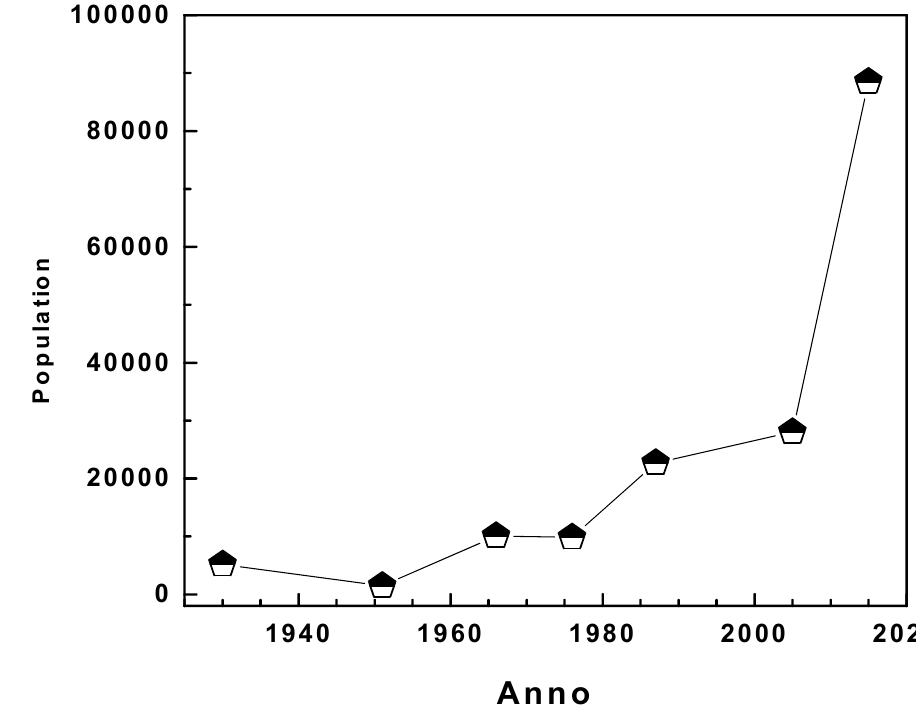
Figure 4. Time-dependent changes of the population in the city of Bangangté. Data compiled from refs. [27,28,31,39,40].